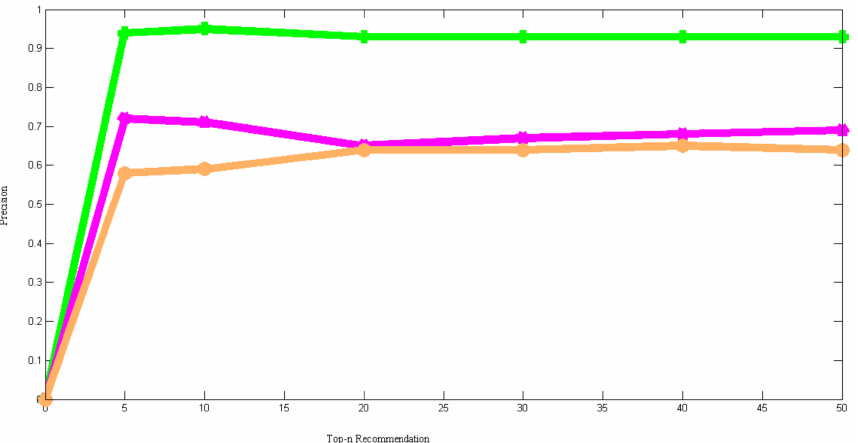
Figure 6. Precision according to the Topn